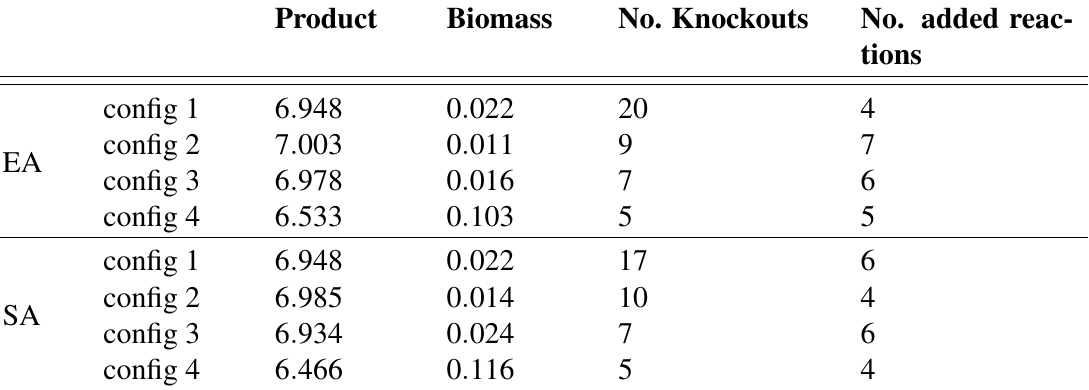
Table 3: Best results of strain optimization for vanillin production using the Yield objective func- tion for each algorithm (EA and